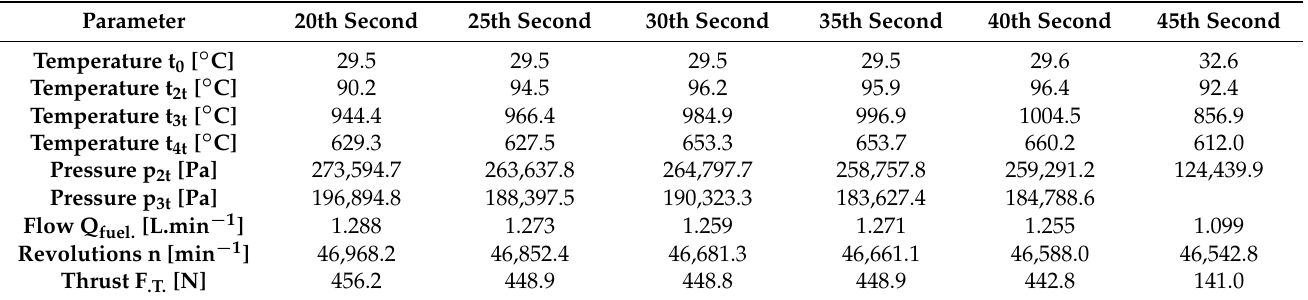
Figure 7. Graphic course of changes in SJE-20 parameters when using a mixture of 70% Jet A-1 aviation kerosene and 30% FAME biofuel. Table 9. Blend of 70% Jet A-1 aviation kerosene and 30% FAME biofuel, 1st launch (40th